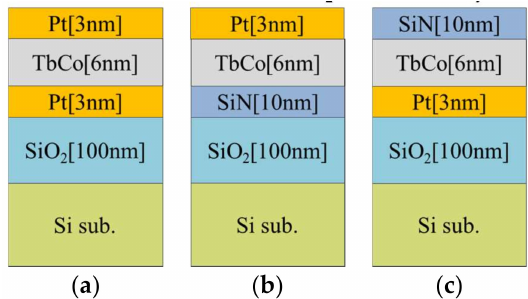
Figure 1. Sample structures. Each sample was deposited on a thermally oxidized silicon (SiO 2 100 nm) substrate (0.3 mm) ( a ) Pt (3 nm)/TbCo (6 nm)/Pt(3 nm), ( b ) Si 3 N 4 (10 nm)/TbCo (6 nm) /Pt(3